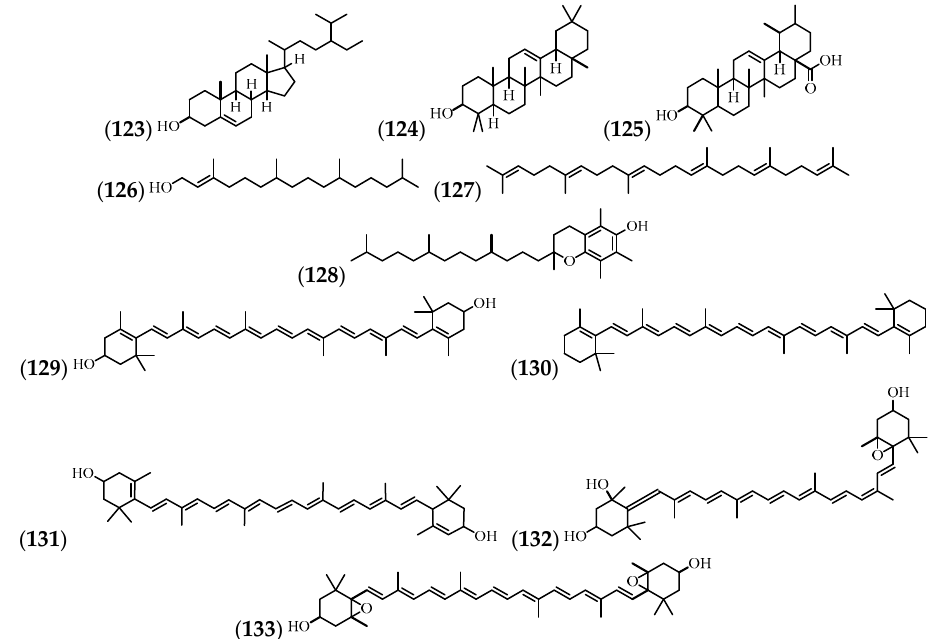
Figure 8. The structures of the steroids and terpenes from A. cathartica.